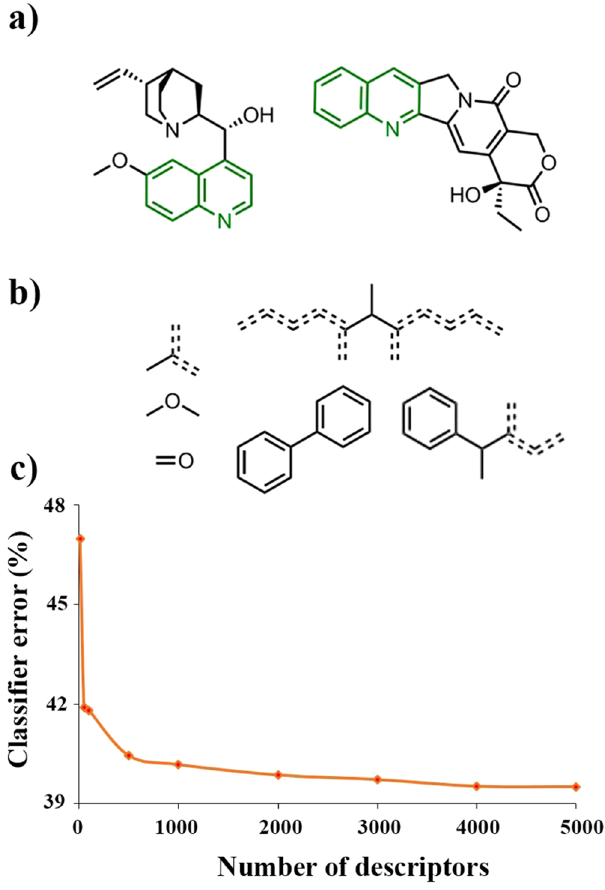
Figure 5. Classification based on chemical-linguistic descriptors. ( a ) An example showing two organic molecules and their maximal common substructure – such substructures computed over millions of molecule- molecule pairs can be used as chemical-linguistic descriptors, CLDs. ( b ) Examples of some smaller and larger CLDs used as descriptors to predict reaction yields and times. Dashed lines denote aromatic bonds. ( c ) Performance of a random forest classifier based on various numbers of CLDs. Even for 5,000 descriptors, the misclassification error is still ca.